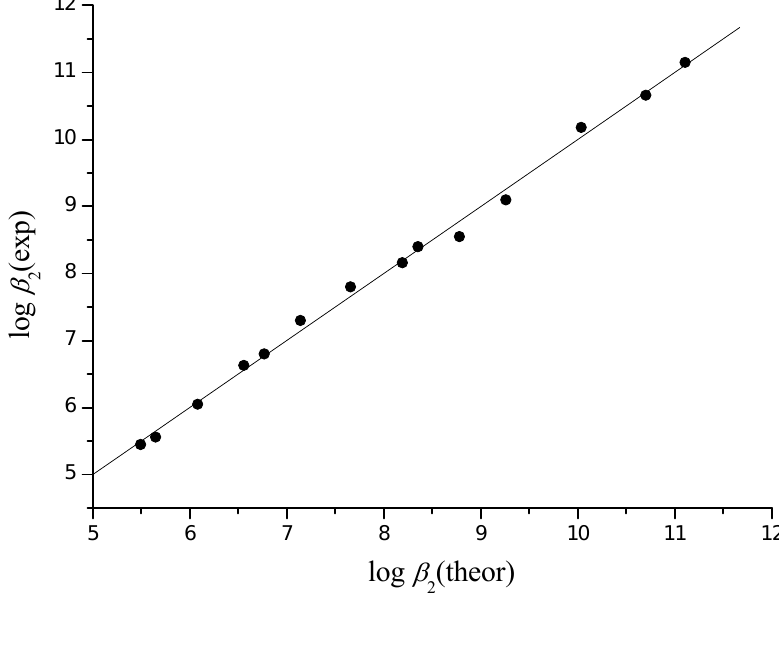
for Mn 2+ , Fe 2+ , Co 2+ , and Ni 2+ complexes 2 = cv